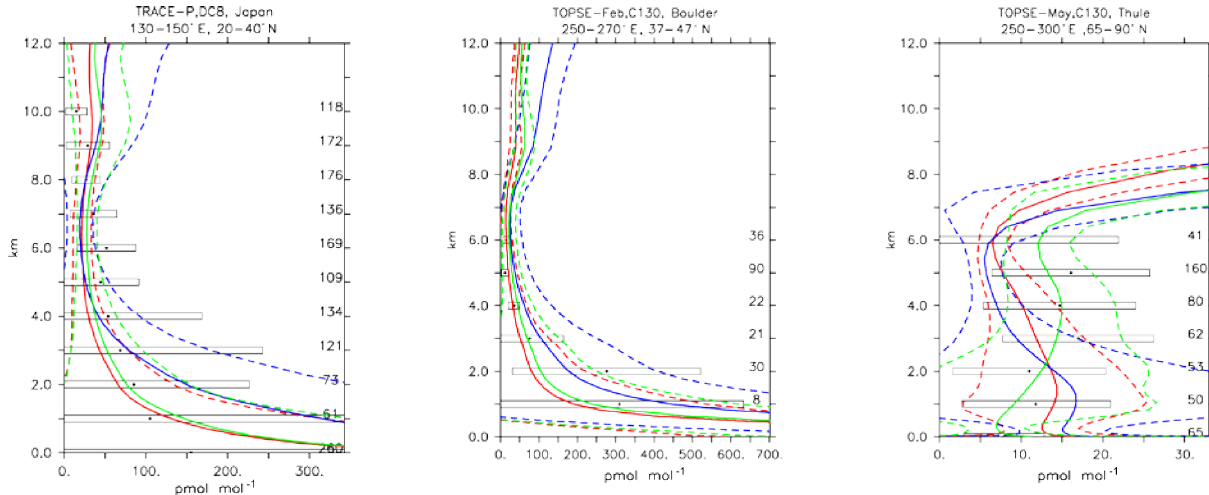
Figure 17. Comparison of daytime NO 2 vertical profiles simulated by CBA (red), MOC (blue) and MOZ (green) chemistry versions against aircraft data (black). Line styles and symbols have the same meaning as in Fig. 12.